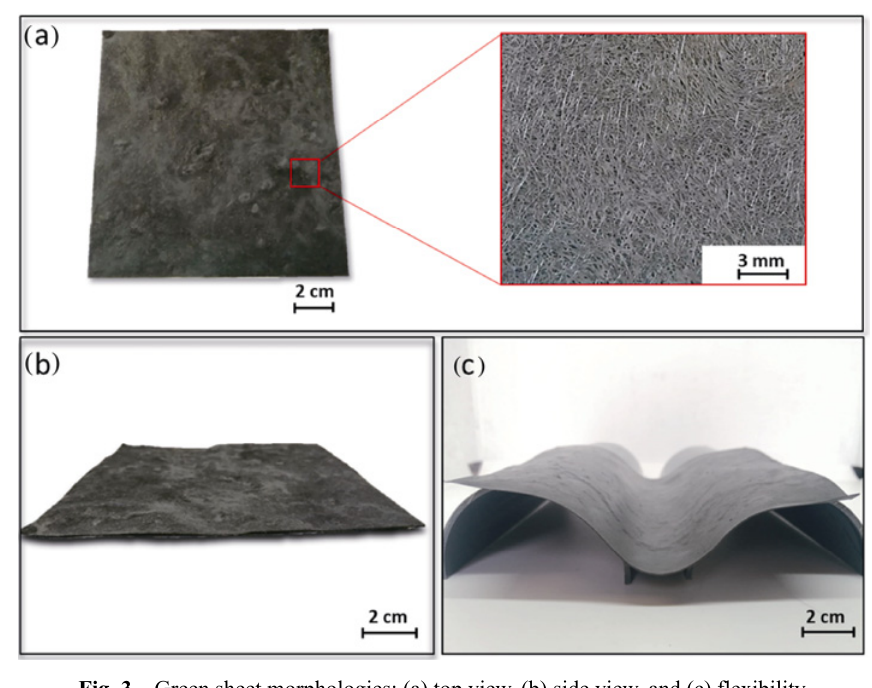
Fig. 3 Green sheet morphologies: (a) top view, (b) side view, and (c) flexibility.